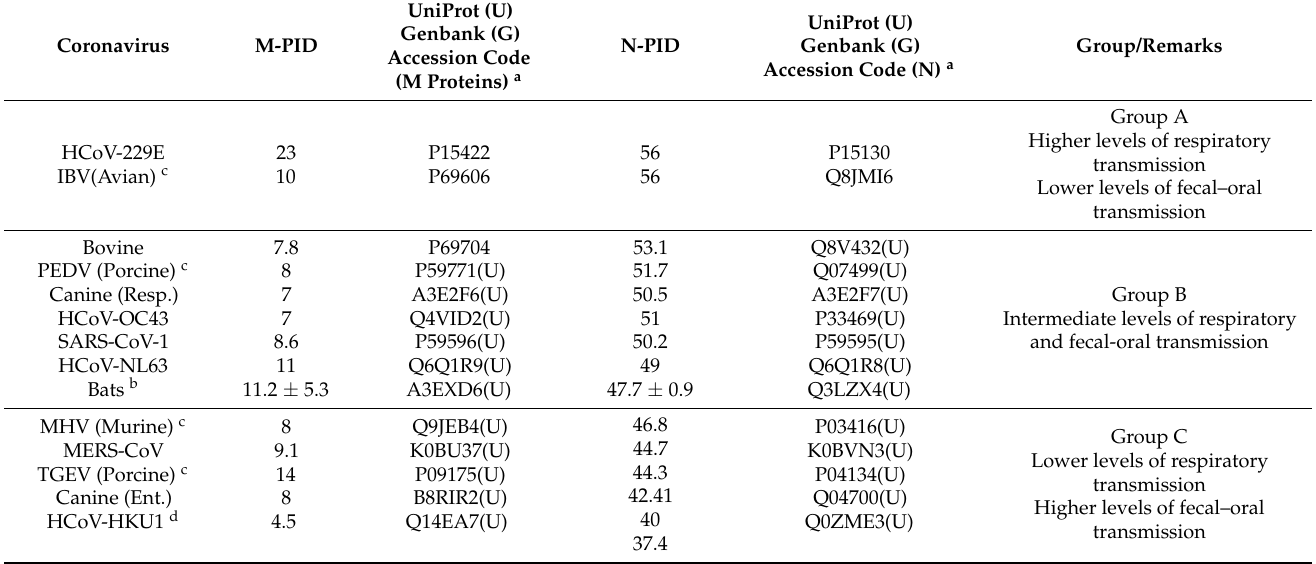
Table 1. Categorization of CoVs by N- and M-PIDs to predict levels of the respiratory and fecal-oral transmission ( p < 0.001, r = 0.8, N = 32). The original model involved categorization mainly by N-PID, and group D was not included. The updated model integrates new knowledge arising from SARS-CoV-2 and